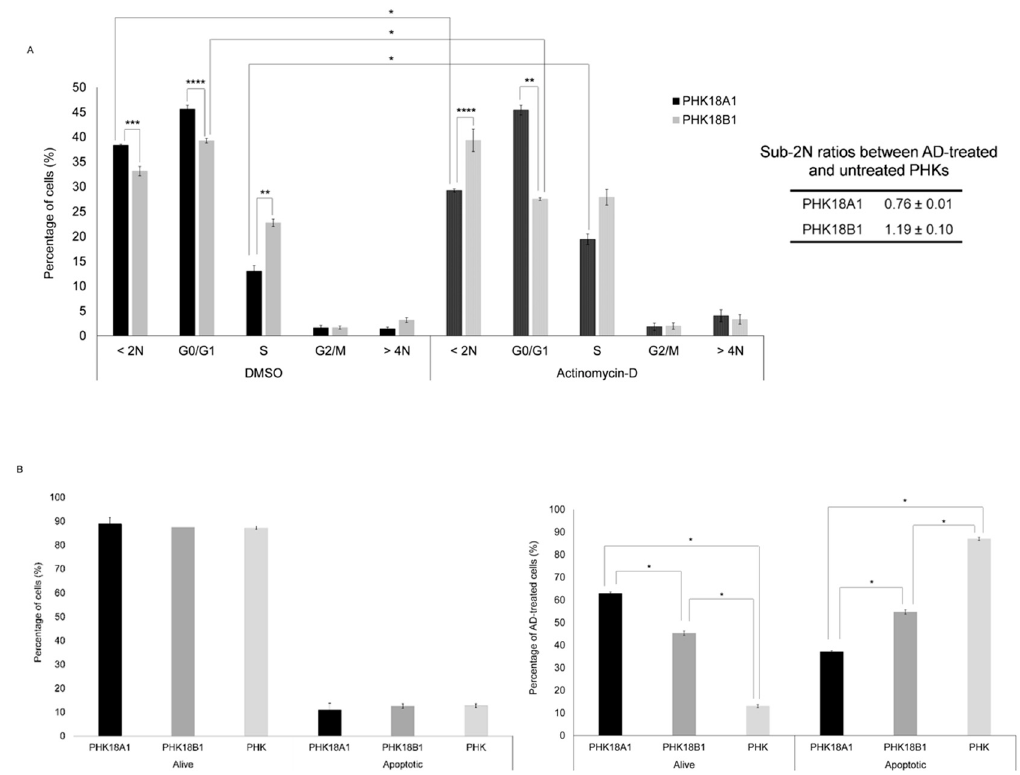
Figure 3. Response of immortalized PHK18A1 and PHK18B1 to actinomycin-D (AD) treatment: ( A ) Cell cycle arrest response to AD treatment. Cells were incubated with AD (0.5 nM) or DMSO for 24 h before incubation with propidium iodide 20 µg/mL. The distribution of cells in each phase of the cell cycle was accessed by flow cytometry. Average of three independent experiments conducted in triplicate; ( B ) apoptosis response to AD treatment. Cells were treated or not with AD (0.5 nM) for 24 h and after six days the activities of caspases 3 and 7 were evaluated by flow cytometry. The T -test was used for statistical analysis. * p = 0.00, ** p = 0.01, *** p = 0.02, **** p = 0.04.